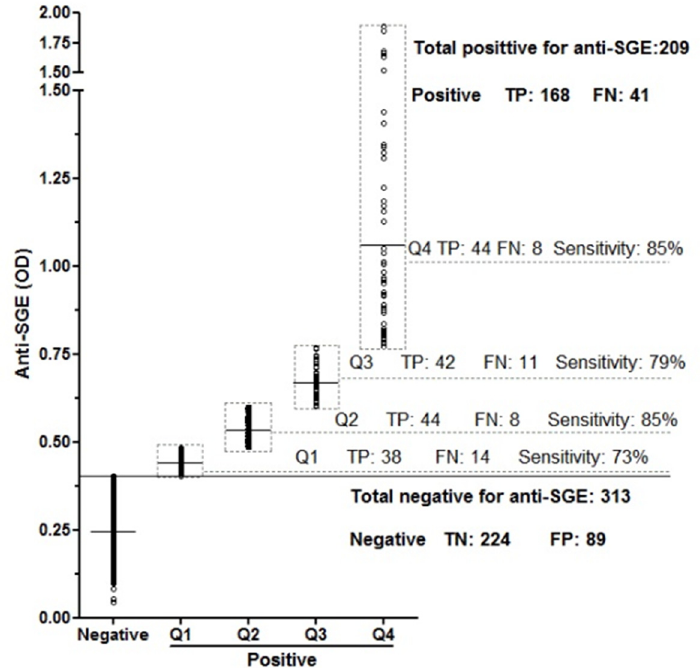
Fig 4. Validation of rPpSP32 as a marker of human exposure to P . papatasi saliva. A total of 522 individuals from endemic area 2 were tested for anti-SGE and anti-rPpSP32 antibodies. The anti-SGE antibody titers (OD) were grouped into quartiles (Q). For each quartile, the sensitivity, the number of true positives (TP) and false negatives (FN) are shown. For anti-SGE negative sera, the numbers of true negatives (TN) and false positives (FP) are